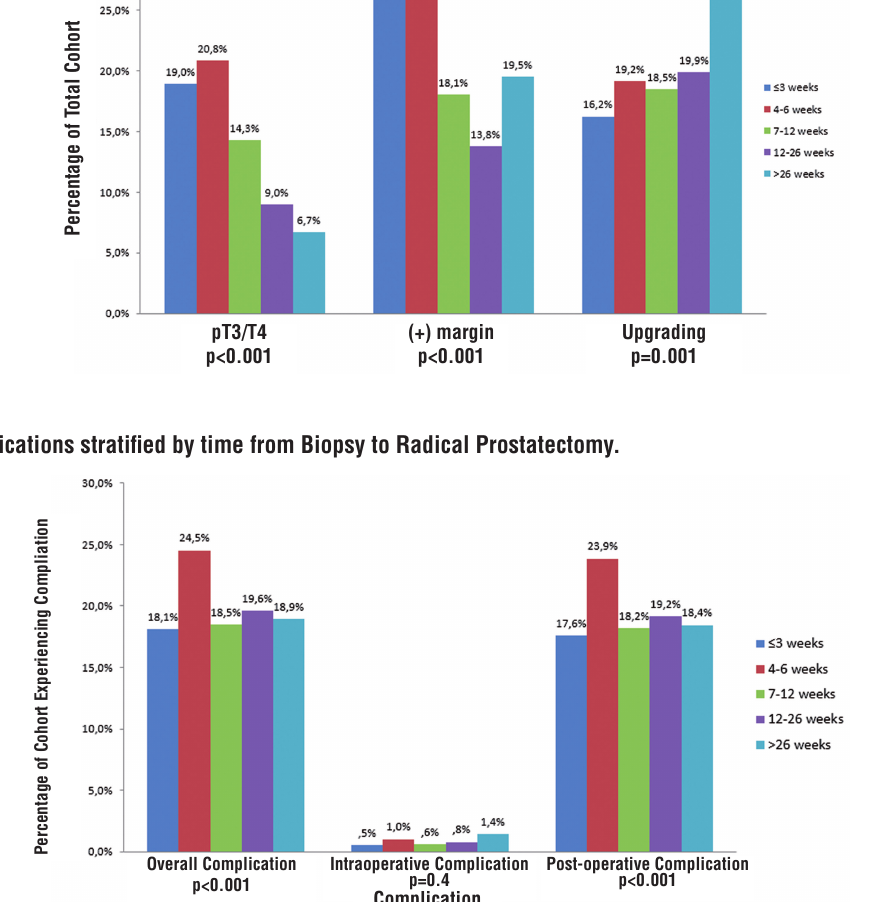
Figure 1 - Pathologic outcomes stratified by Time from Biopsy to Radical Prostatectomy.